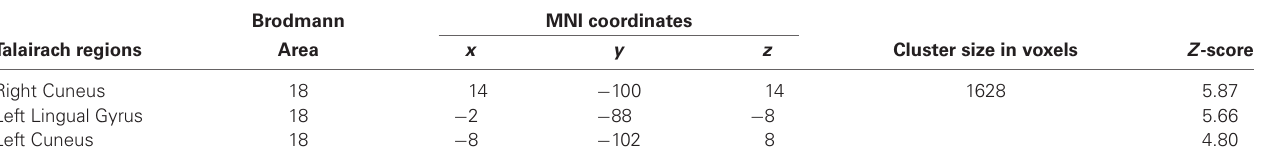
FIGURE 4 | Activations in the contrast: aesthetic appreciation of all paintings > corresponding all photographic analogs . The comparison of aesthetic appreciation of 15 paintings versus corresponding 15 photographic